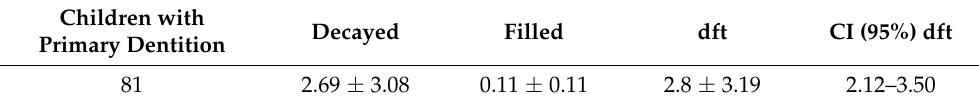
Table 9. Average number of decayed and filled teeth in primary dentition (dft).